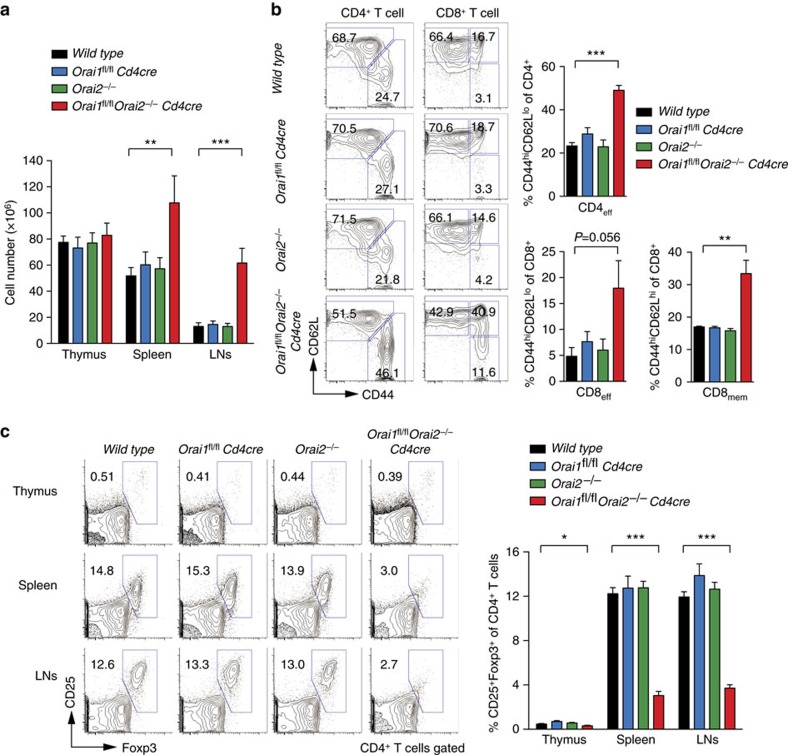
Reduced Treg numbers and disrupted immune homeostasis in Orai1/Orai2-deficient mice.(a) Cell numbers in the thymus, spleen and LNs of WT, Orai1fl/flCd4cre, Orai2−/− and Orai1fl/flOrai2−/−Cd4cre (DKO) mice; means±s.e.m. of 9–11 mice. (b) Analysis of CD44hiCD62Llo effector CD4+ and CD8+ T cells and CD44hiCD62Lhi memory CD8+ T cell subsets in the spleen of WT, Orai1fl/flCd4cre, Orai2−/− and DKO mice by flow cytometry; means±s.e.m. of four mice. (c) Analysis of CD4+CD25+Foxp3+ Treg cells in the thymus, spleen and LNs of WT, Orai1fl/fl
Cd4cre, Orai2−/− and DKO mice by flow cytometry; means±s.e.m. of 9–11 mice. *P<0.05; **P<0.005; ***P<0.001 in (a–c) using unpaired Student's t-tests.